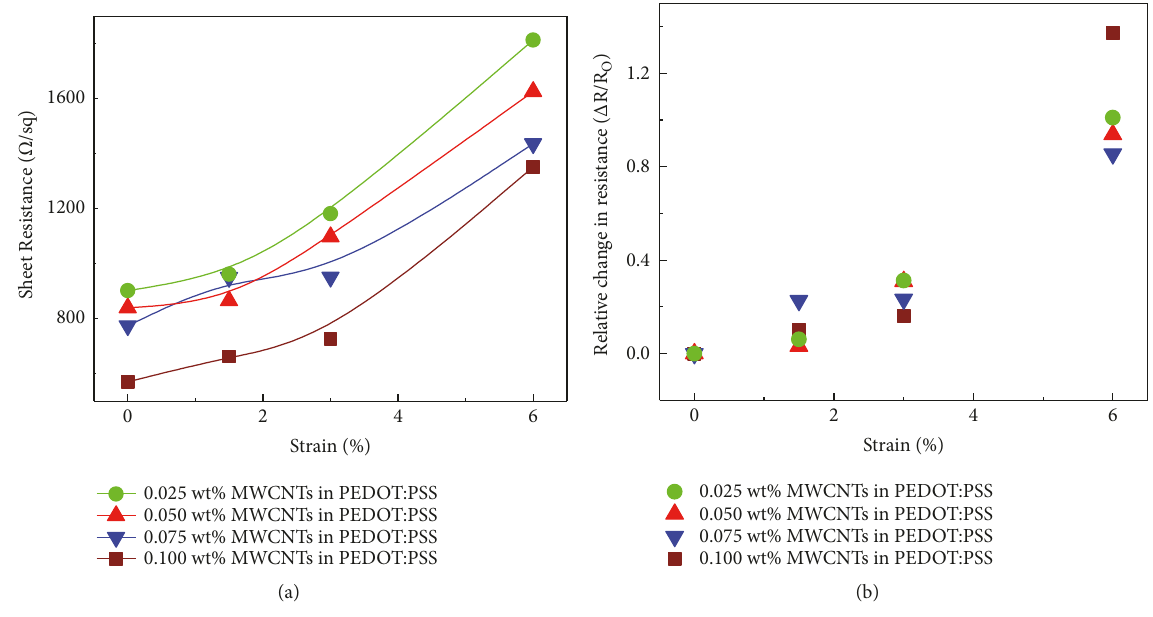
Figure 9: (a) Sheet resistance of MWCNT-PEDOT: PSS film increases with increasing Strain % for different wt% of MWCNT. (b) Relative change in resistance of MWCNT-PEDOT: PSS film increases with increasing Strain% for different wt% of MWCNT. Table 2: Gauge factor of nanocomposite thin